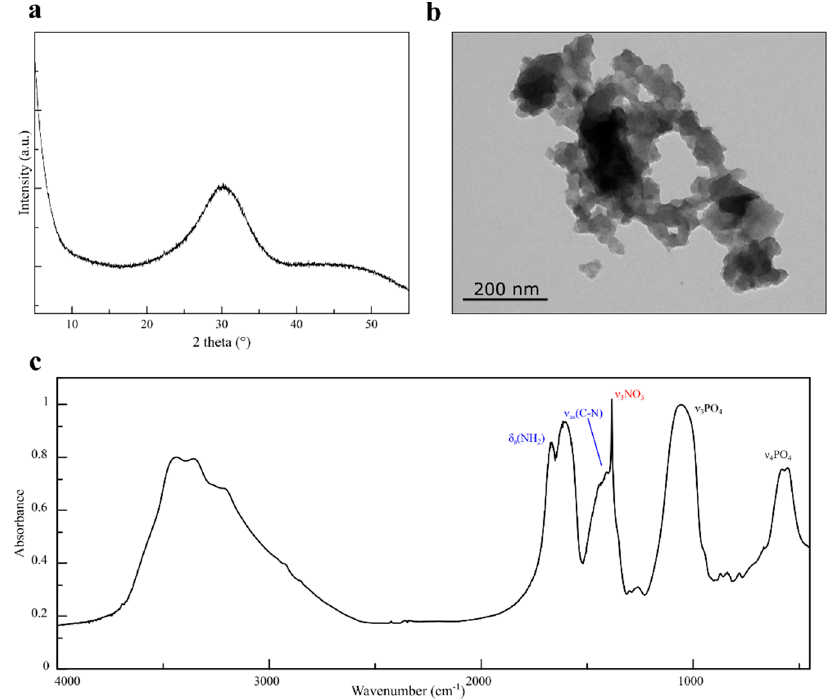
Figure 2. XRD diffraction trace ( a ), TEM image ( b ), and FTIR spectrum ( c ) of U-ACP nanoparticles confirming the successful functionalization of ACP with urea and nitrate. Vibrational modes of both N-containing dopants are depicted in blue and red respectively.